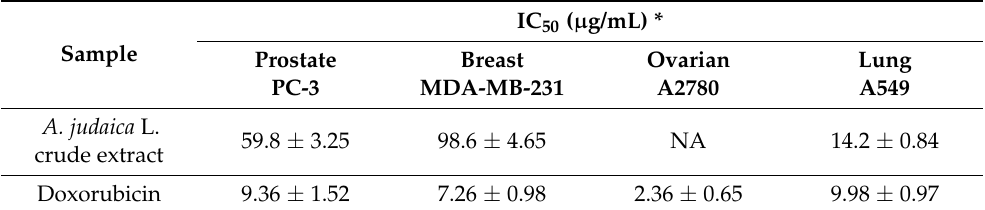
Table 2. Cytotoxic activity of ethanolic crude extract of A. udaica L. against prostate, breast, ovarian, and lung cancer cell lines using the MTT assay.